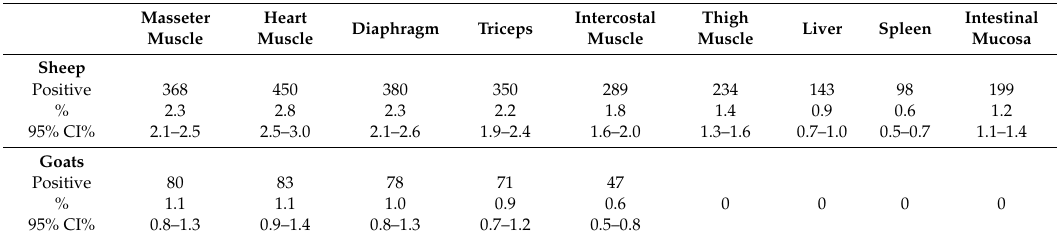
Table 2. Prevalence of Taenia ovis cysticercosis in sheep (16,180) and goats (7560), by tissue, from the Najafabad abattoir, Isfahan, Iran,